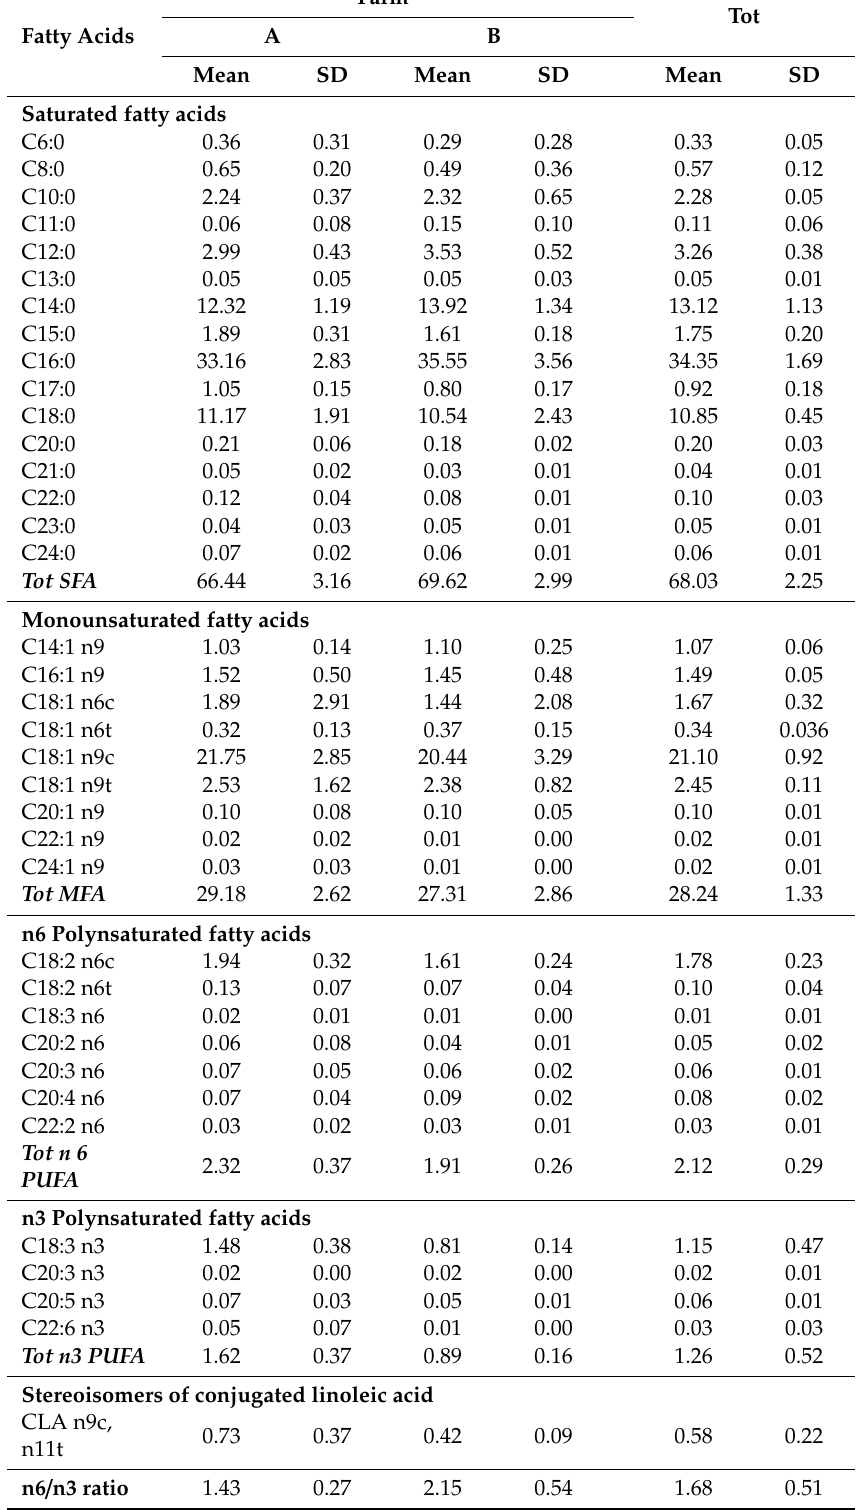
Table 2. Mean and SD of detected fatty acids in cheese from A (grazing system) and B (no-grazing system)